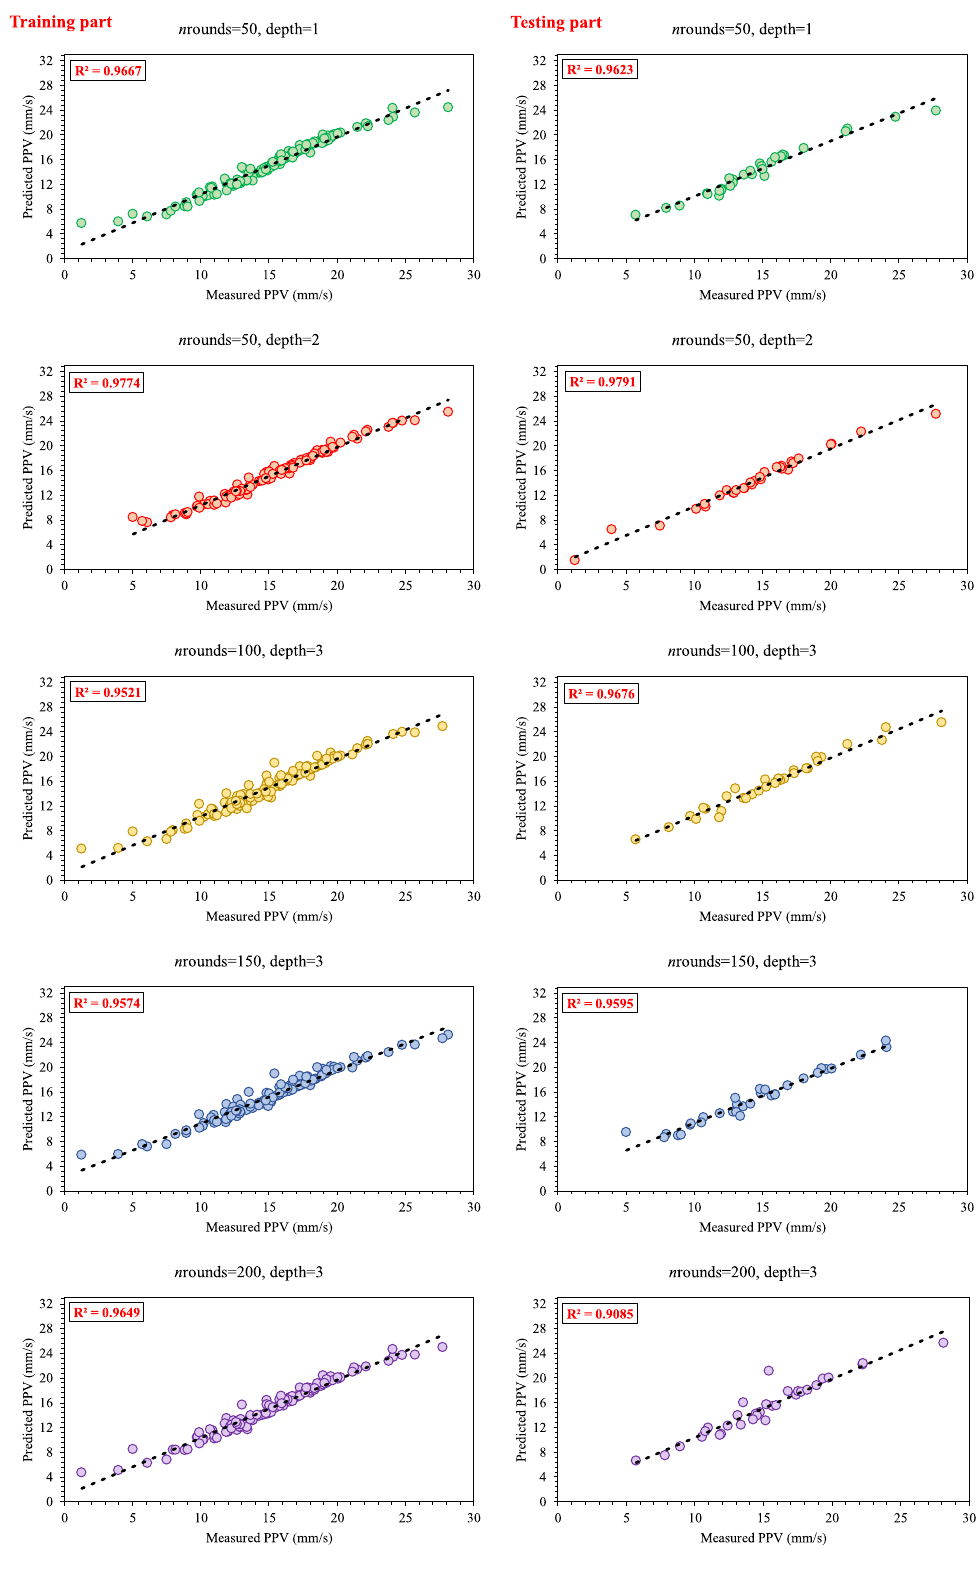
Figure 7. Correlation graph between predicted PPV by various XGBoost base models and measured